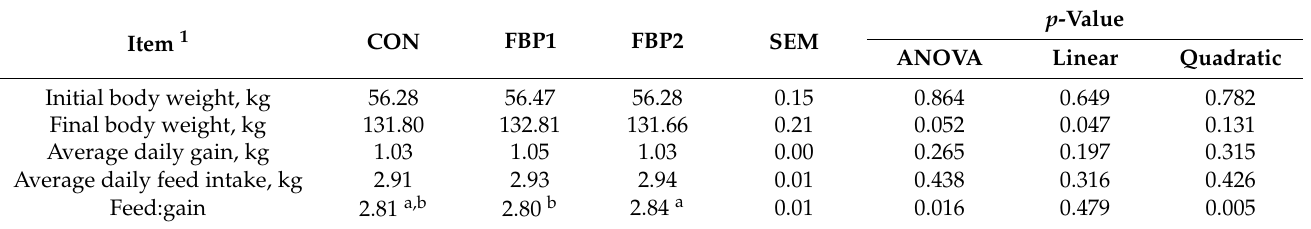
Table 2. Effects of fermented bamboo powder supplementation on growth performance of growing– finishing